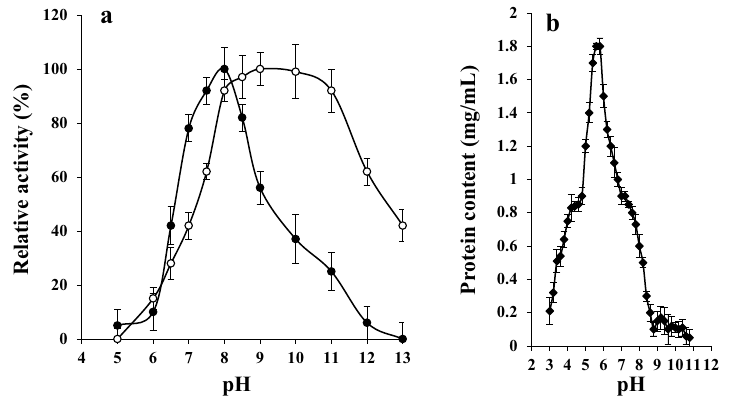
Figure 4. Impact of pH on both the proteolytic activity (- ● -) and the stability (- ○ -) ( a ). The reaction temperature was adjusted to 35 °C in the presence of azocasein. The pH stability of the pure enzyme was inspected by its incubation without the substrate at 35 °C for 60 min with various pHs, then the remaining enzymatic activity was assessed at a pH value of 8.0. The isoelectric pH based on the protein precipitation pattern is shown in ( b ). There is a weak positive correlation between the enzyme activity and its pH stability since the correlation coefficient r = 0.487. The two-tailed P- value is given as 0.109. There is a weak negative correlation between the pH and the precipitated protein since the correlation coefficient r = − 556***. The two-tailed P- value is given as 0.000 and the estimated regression equation can be expressed as protein content = 1.522–0.122 pH.